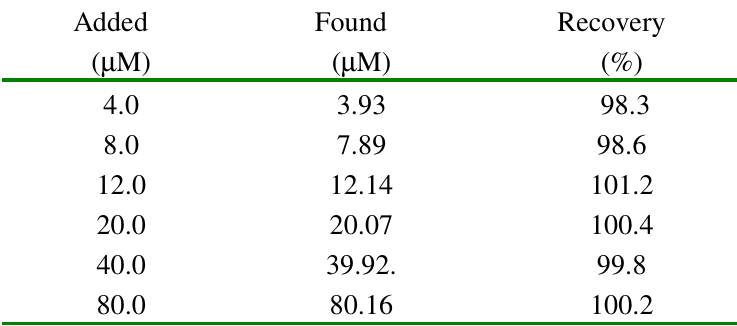
Table 1. The recoveries determined at HRP-Au-SPCE modified